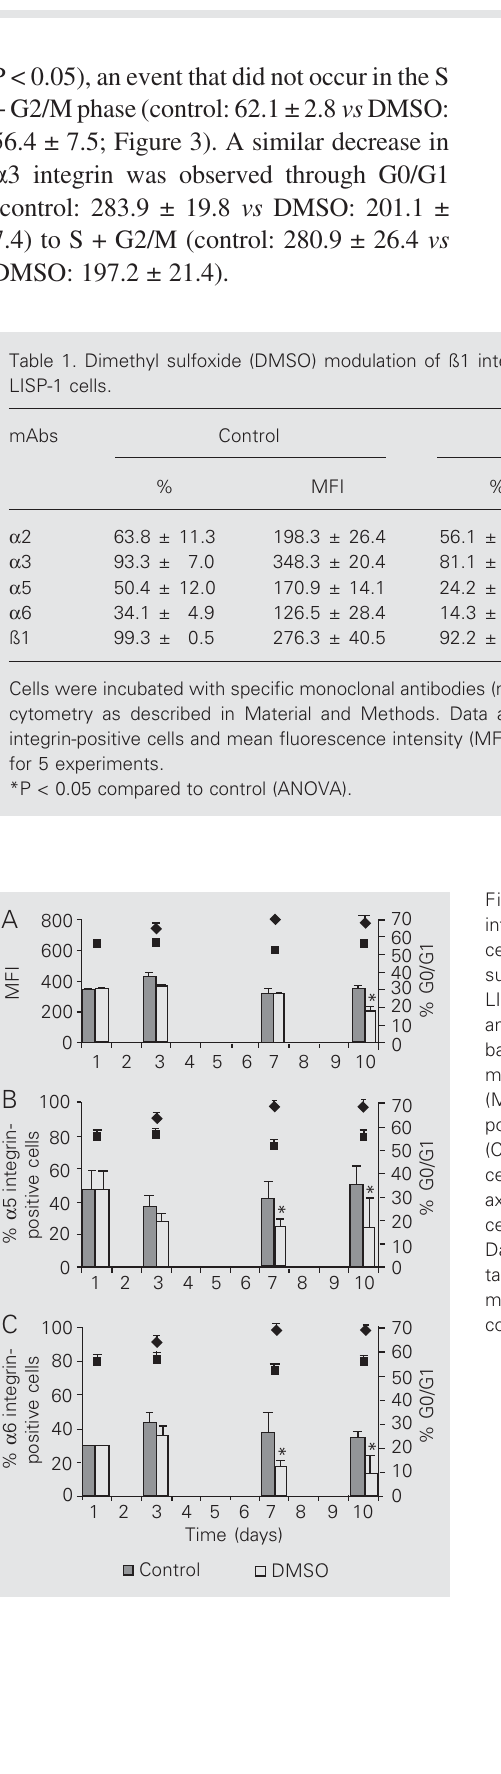
Table 1. Dimethyl sulfoxide (DMSO) modulation of ß1 integrin subunit expression in LISP-1 cells. mAbs Control DMSO